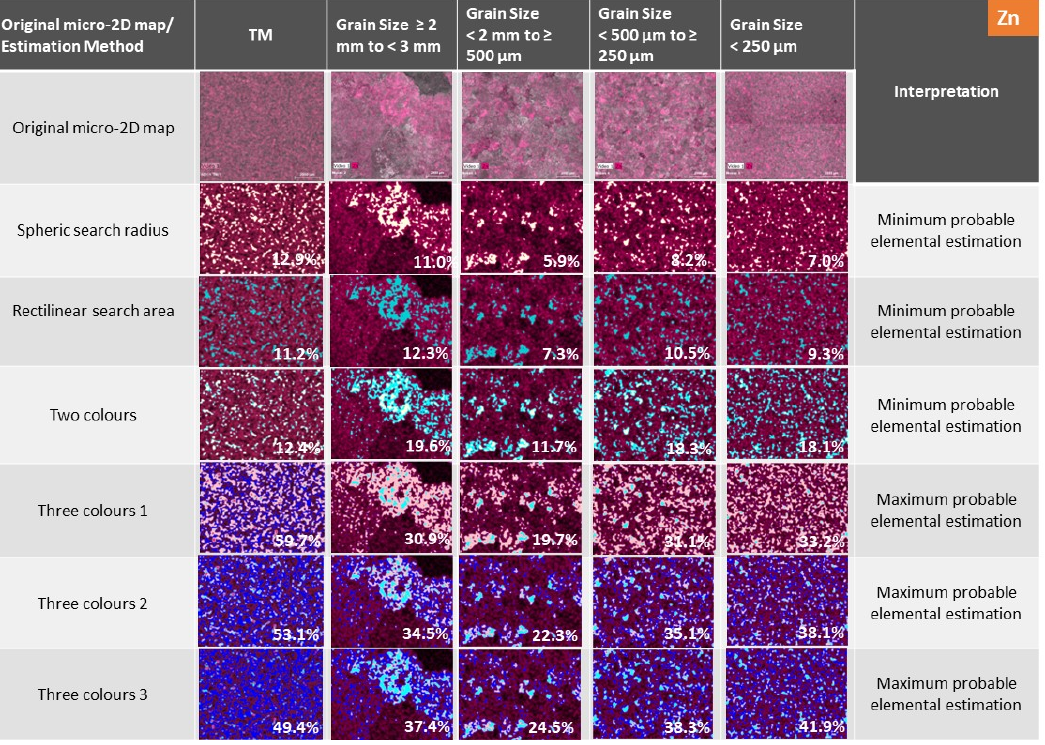
Figure A4. Minimum and maximum probable elemental occurrence in µ-XRF 2D map (percentage of area %) for Zn.